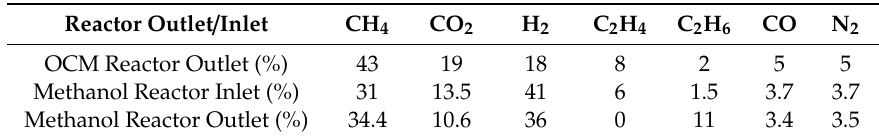
Table 2. Typical observed experimental performance of the sequence of OCM and methanol reactor (The reported percentages are the